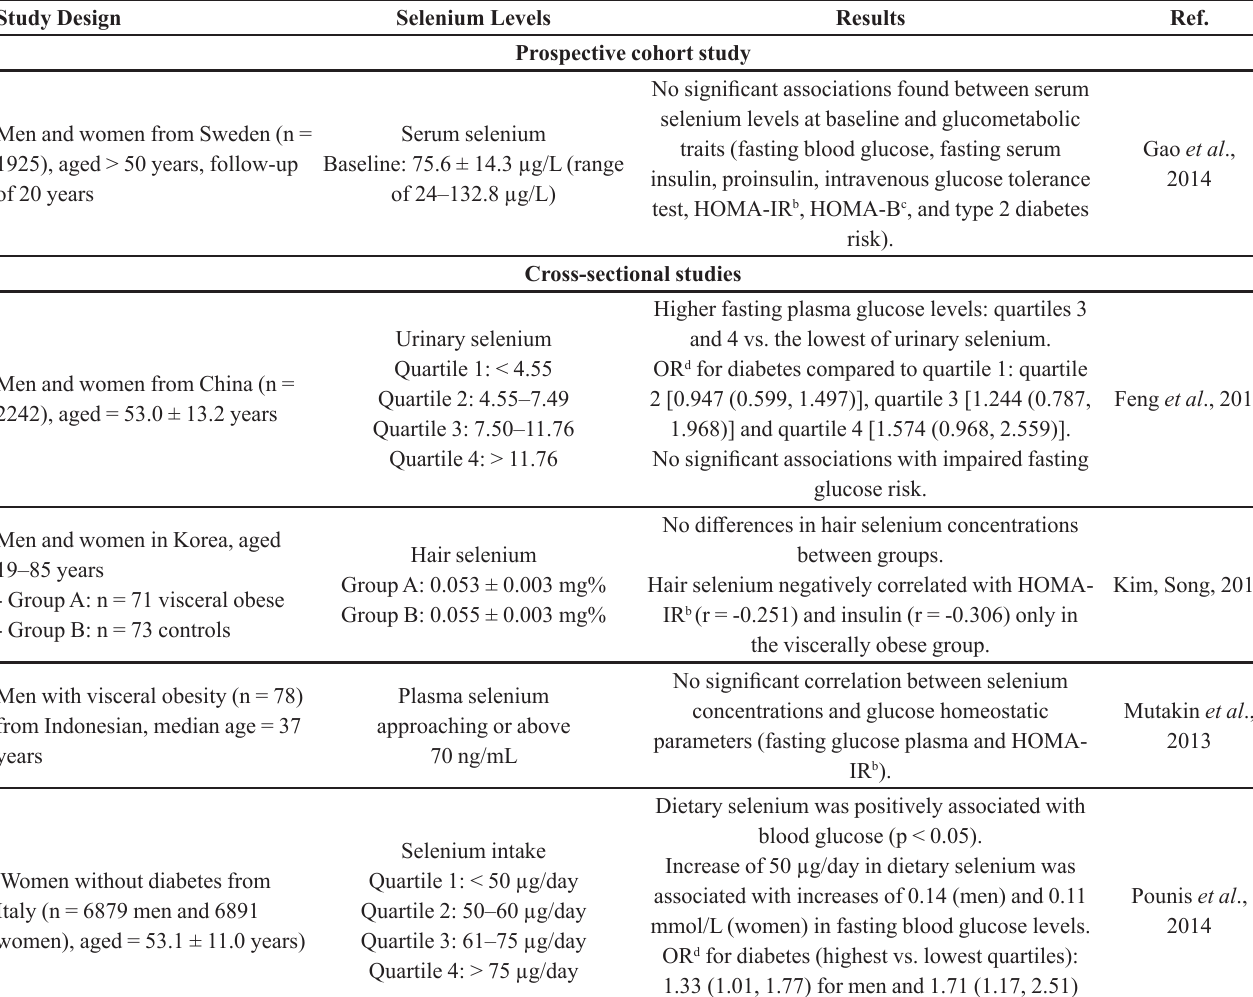
TABLE I - Selenium, glycemic parameters and insulin resistance: a summary of human studies Study